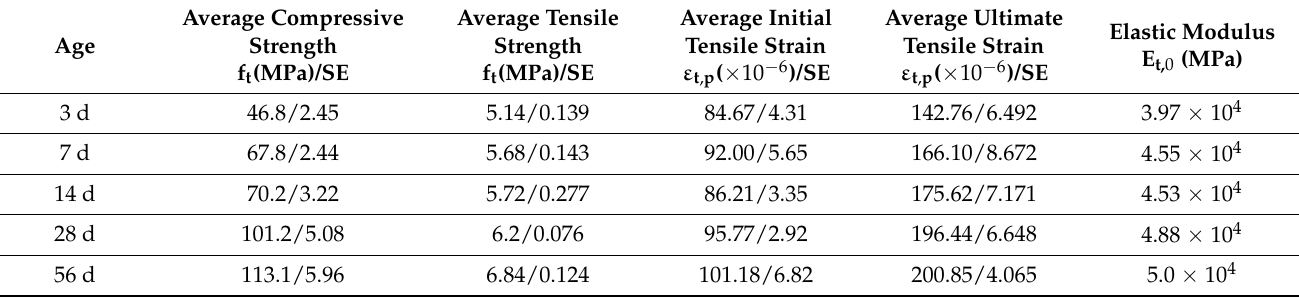
Table 3. Main test results of the RPC axial tension